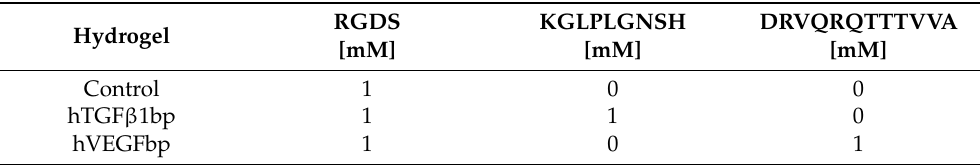
Table 4. PEGDA Binding Peptide (bp) Hydrogel Compositions.